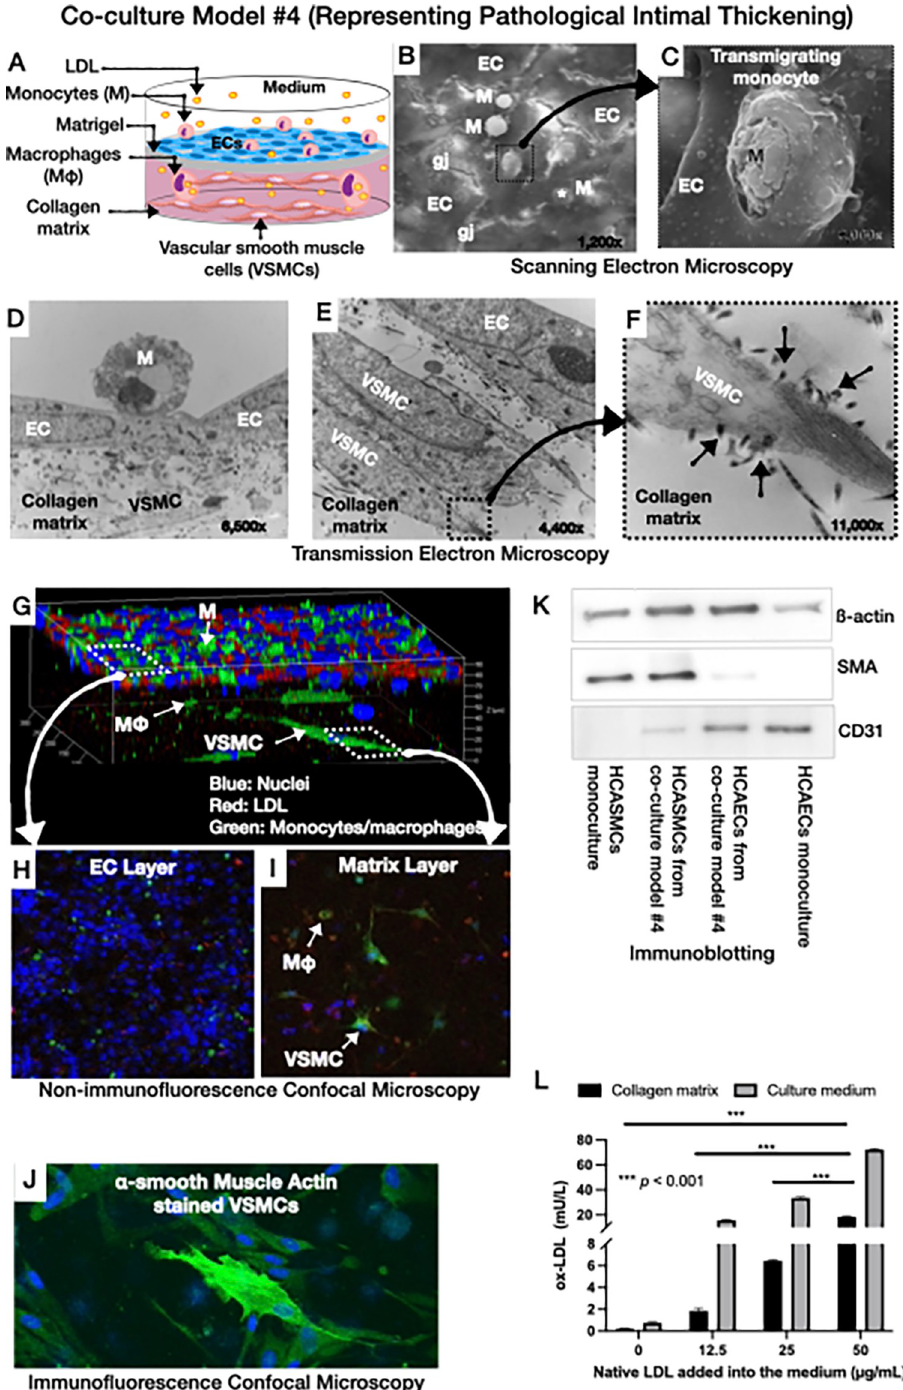
Fig 5. Co-culture model #4 representing pathological intimal thickening. A : Schematic illustration: Addition of LDL and monocytes on top of HCAECs cultured on Matrigel-coated matrix containing layers of HCASMCs, B and C : Scanning electron microscopic images showing the transportation stages of monocytes: Monocytes adhering on the ECs ( B ), transmigrating monocytes through gap junctions ( C ), and transmigrant monocytes (white asterisks in B ), D-F : Transmission electron microscopic images showing monocytes adhering on the ECs ( D ), and layers of spindle- shaped VSMCs in the collagen matrix ( E ) with characteristic surface connections with neighboring collagen fibers (black arrows in F ), G-I : 3D images of the co-culture by non- immunofluorescence confocal microscopy showing the